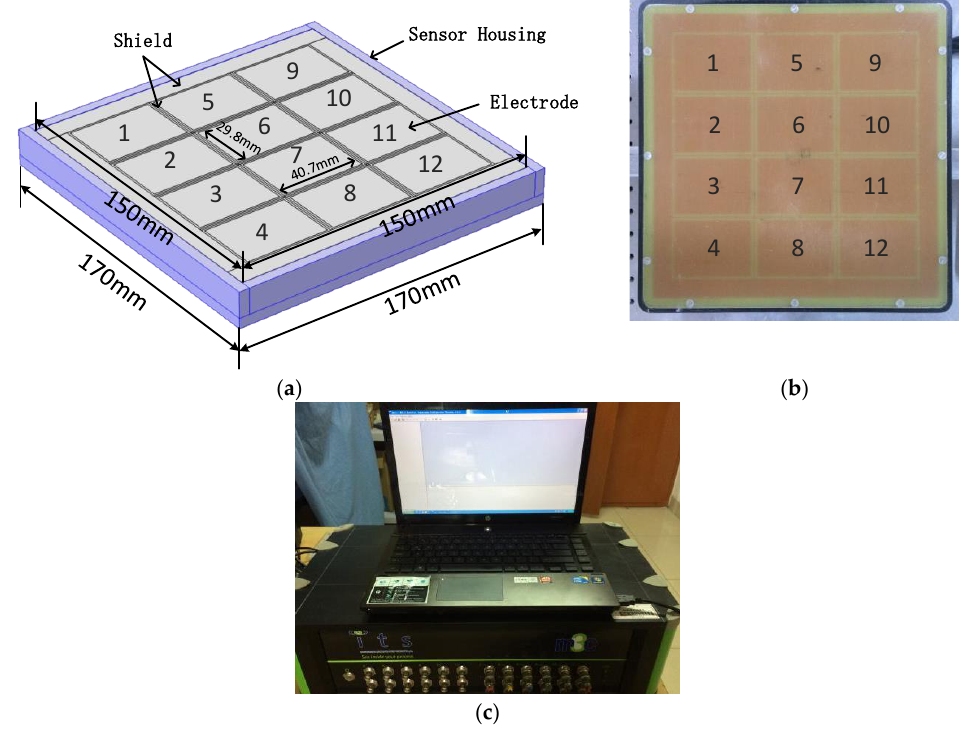
Figure 1. Coplanar array electrode capacitance detection system: ( a ) model of coplanar array electrode sensor; ( b ) planar array 3 × 4 electrode sensor; and, ( c ) Industrial Tomography Systems (ITS) 24-channel electrical capacitance tomography (ECT) M3C system.